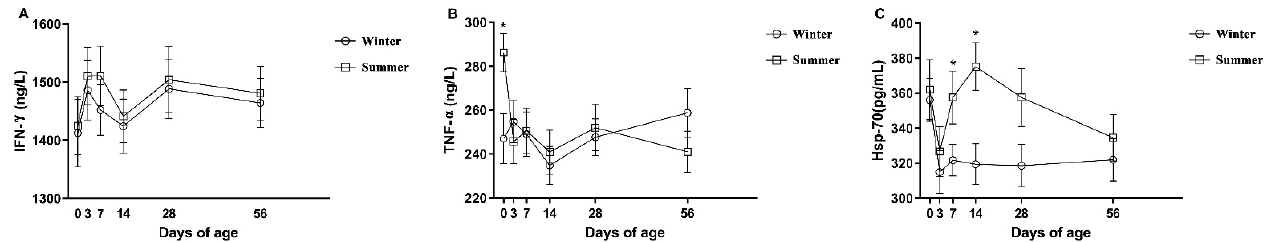
Figure 5. Seasonal heat stress in late gestation changes in plasma immune indexes at different ages in calves. Including ( A ) IFN- γ concentration of plasma, ( B ) TNF- α concentration of plasma, ( C ) hsp-70 concentration of plasma. Error bars represent SEM. Significance is indicated at p < 0.05 (*). Table 4. Plasma metabolism and endocrine concentrations of calves before weaning in summer and winter.